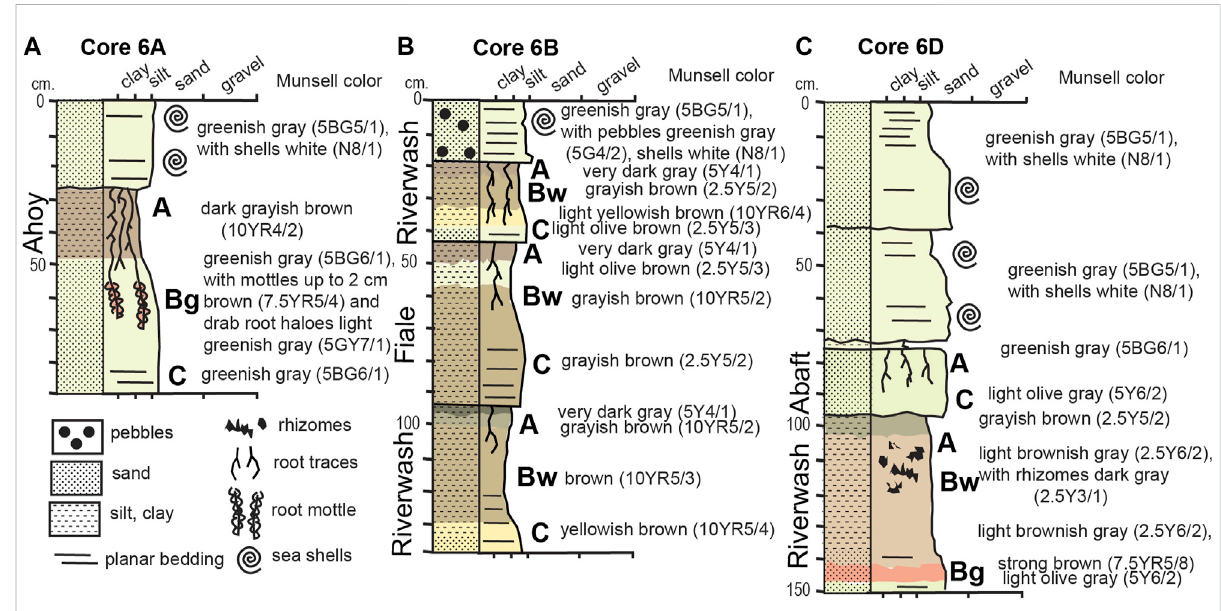
FIGURE 6 Graphic log of cores 6A, 6B, and 6D showing positon and type of paleosols in each core and the location of features such as root traces, root mottle, and